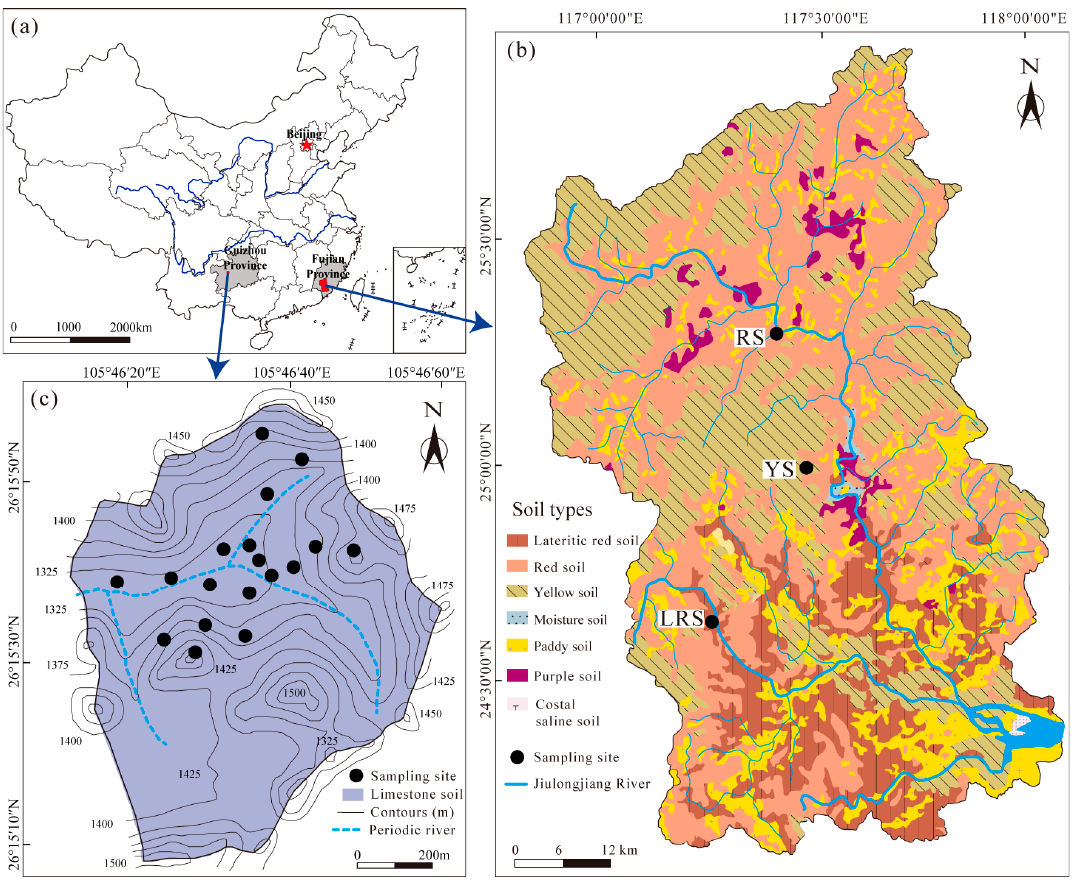
Figure 1. Location of study areas ( a ) and sampling sites in Jiulongjiang River Catchment ( b ) and Chenqi Catchment ( c ). Table 1. Comparison of Jiulongjiang River Catchment and Chenqi Catchment.